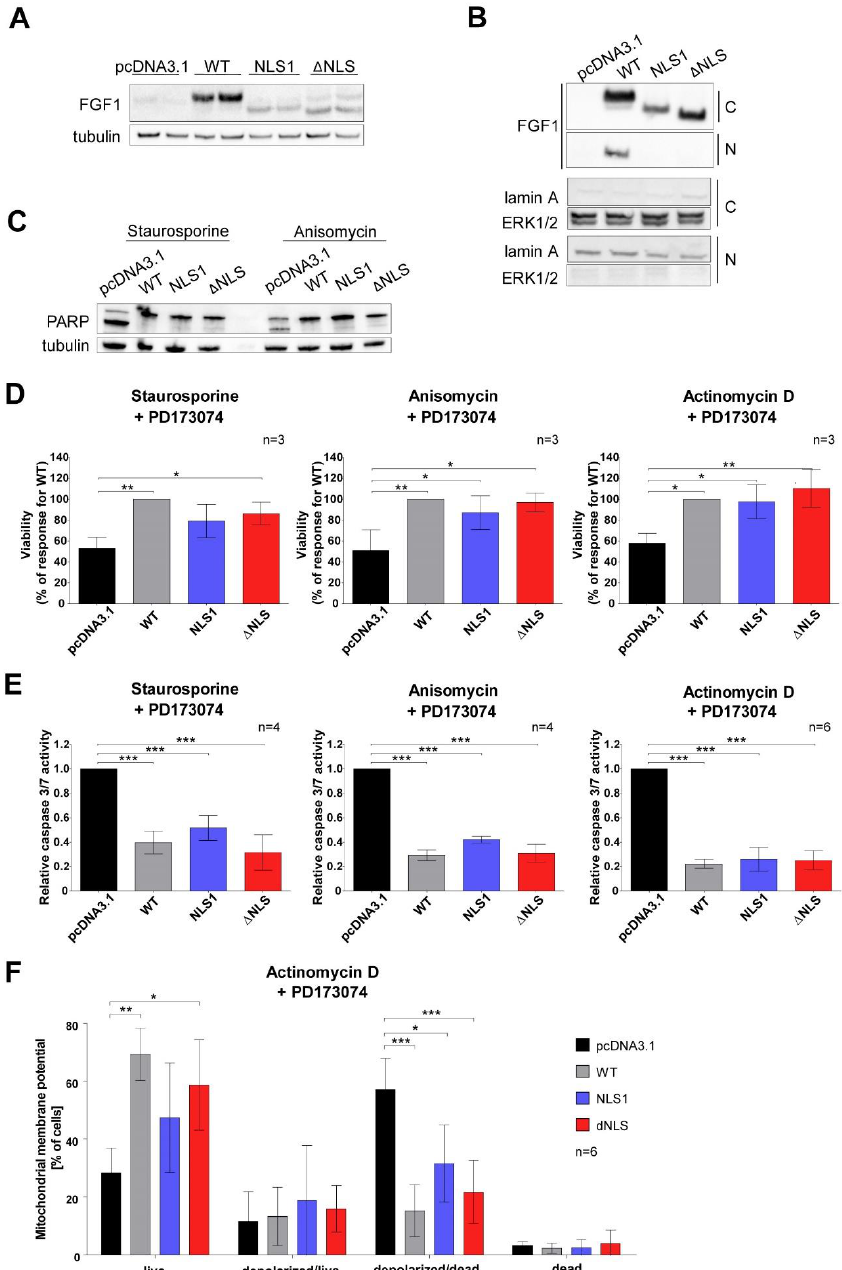
Figure 5. Anti-apoptotic activity of stably expressed FGF1. U2OS cells were stably transfected with vectors encoding wild type FGF1 (WT) and its mutated variants (NLS1 and ΔNLS). ( A ) The presence of pools of individual endogenous FGF1 variants in the lines was verified by Western blotting. ( B ) The presence of endogenously expressed FGF1 variants in the cytoplasmic (C) and nuclear (N) fractions was confirmed by subcellular fractionation and fraction purity was assessed by detection of the marker proteins, lamin A and ERK1/2 after 6 h serum starvation. ( C ) Cell lines were also treated for 6 h with staurosporine and anisomycin, and PARP cleavage was evaluated by Western blotting. ( D , E ) To induce apoptosis, cells were treated with different stimuli: staurosporine (1 µ M), anisomycin (10 µ M), and actinomycin D (5 µ M) in the presence of FGFR inhibitor (PD173074, 100 nM). ( D ) After 24 h the viability and ( E ) caspase 3/7 activity of cells were determined. ( F ) Mitochondrial membrane potential ( ∆Ψ m) was also measured after 24 h of actinomycin D treatment. Data were normalized to control values and presented as means ± SD from three to six independent experiments. Statistical significance: * p ≤ 0.05, ** p ≤ 0.01, *** p ≤